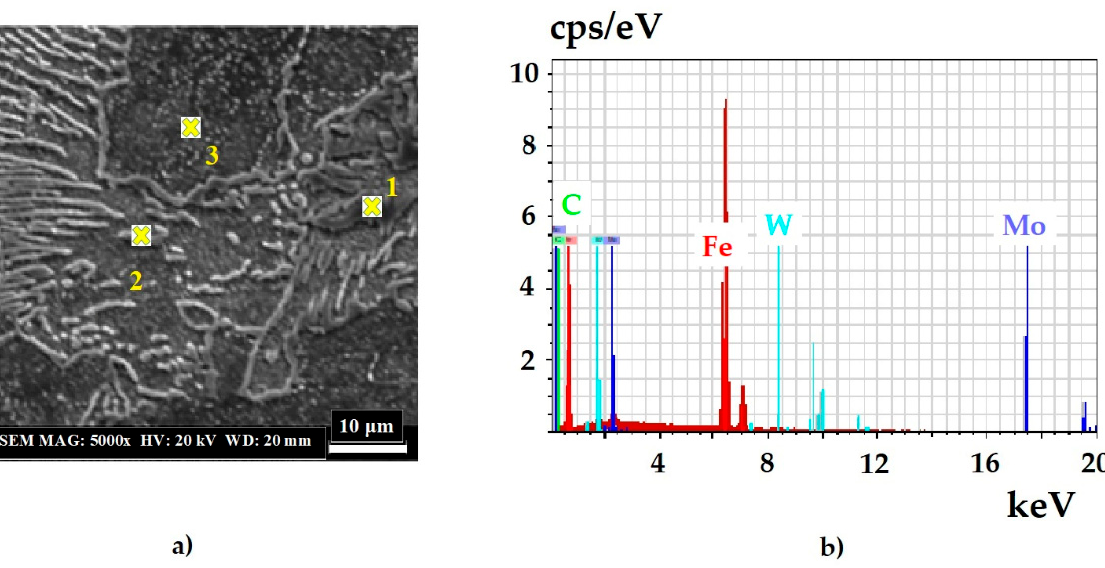
Figure 8. ( a ) SEM micrograph of the HTCS-130 hot work tool steel surface after etching in nital (magnification 5000×), ( b ) example of EDS analysis of position number 2. Table 5. EDS analysis of the positions marked as 1, 2, and 3 in Figure 8a. Chemical Element, Mass. % Position Fe